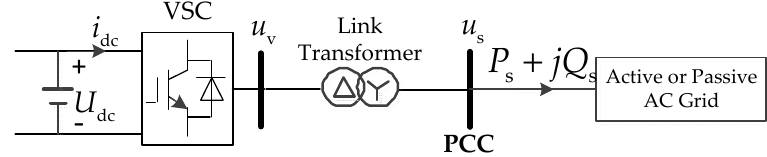
Figure 1. Typical structure of nonsynchronous-machine